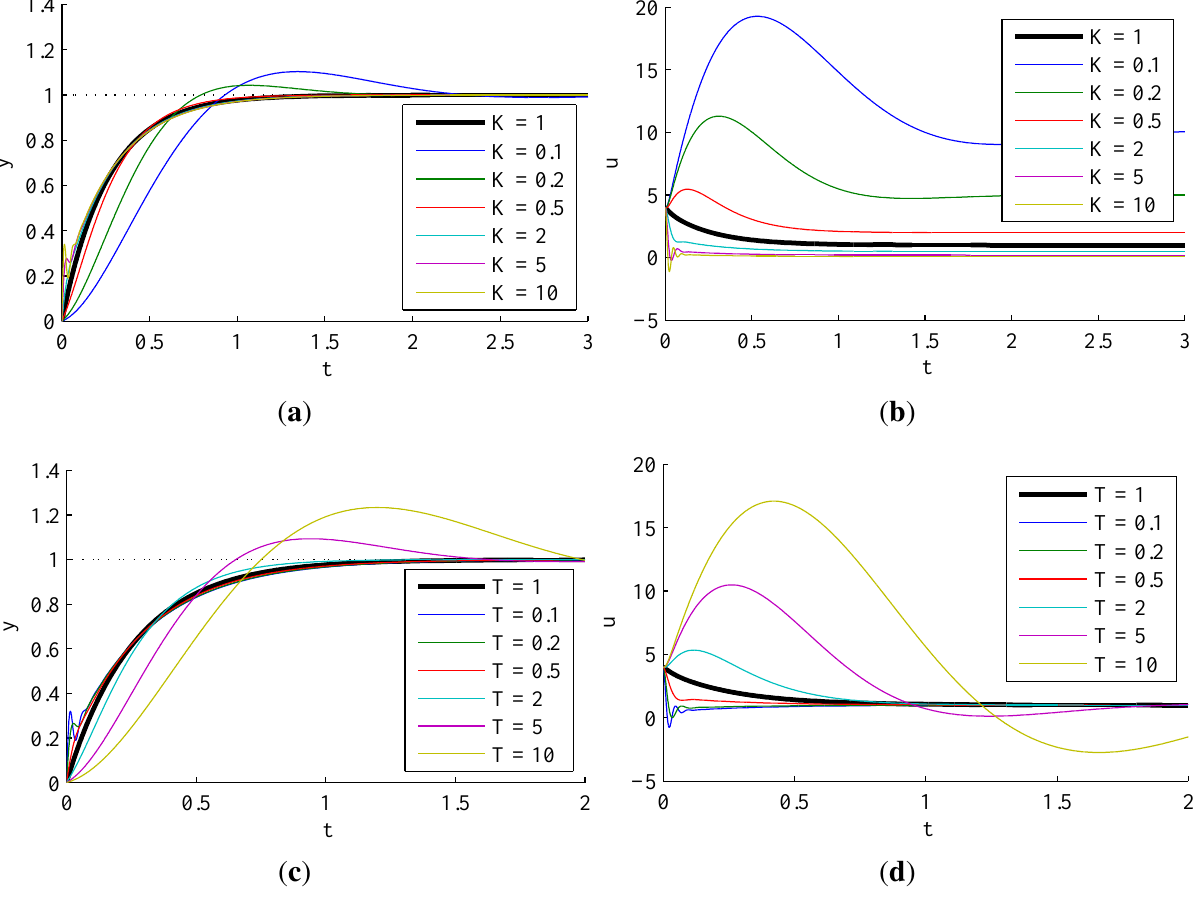
Figure 3. Experiment 3.1.1: fixed first-order ADRC controlling first-order process with varying parameters. Nominal process parameters: K = 1, T = 1. ADRC